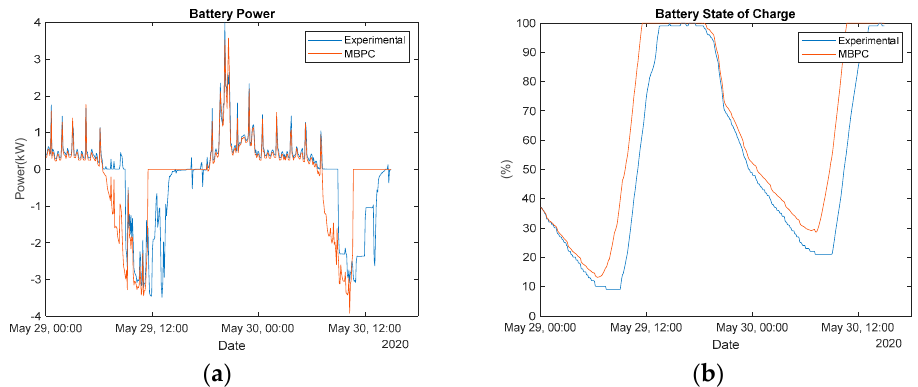
Figure 19. ( a ) Battery Power (sunny day). ( b ) Battery State of Charge (sunny day).